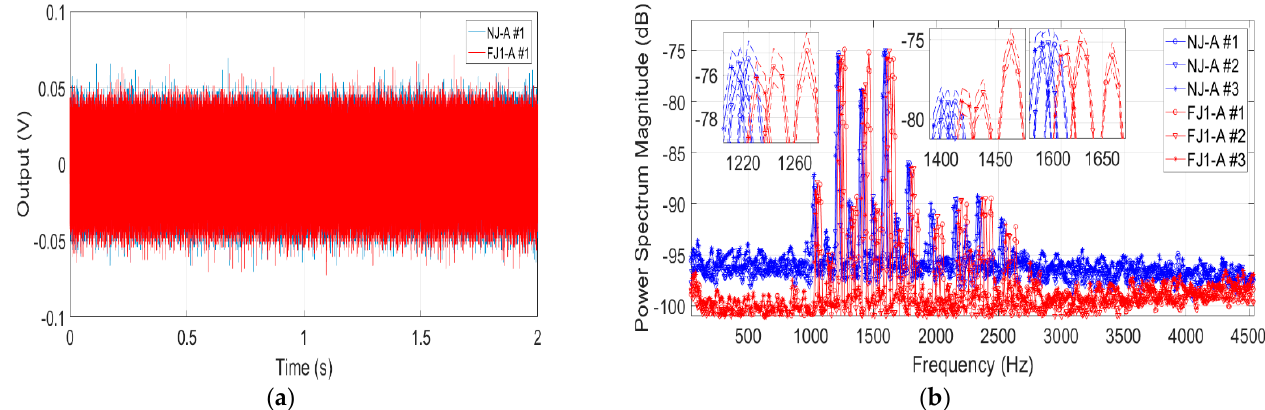
Figure 3. Output signals from test runs with structure-A for the configurations in Section 2.2: ( a ) Typical time histories of NJ-A versus FJ1-A showing no visible differences; ( b ) Spectra of NJ-A versus FJ1-A showing clear frequency shifts for the three largest modes due to failing joint. Dashed lines indicate confidence intervals at 95%